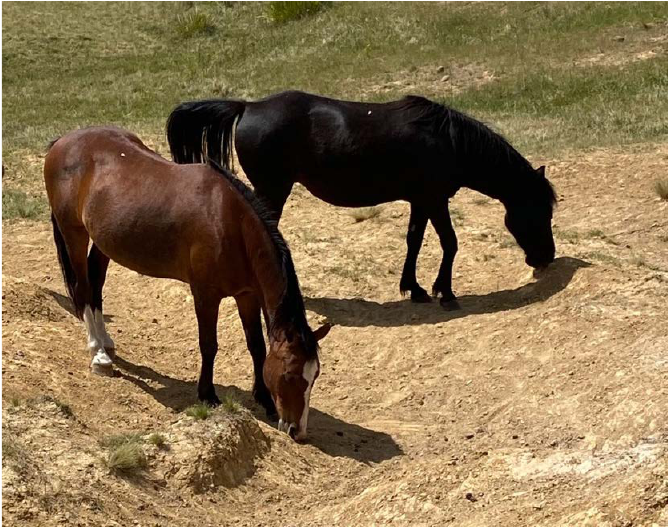
Figure 3. Wild horses exhibiting geophagia. Image A. M. Harvey.